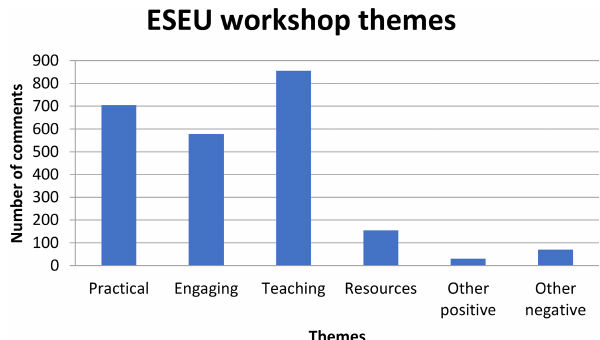
Figure 4. Workshop theme